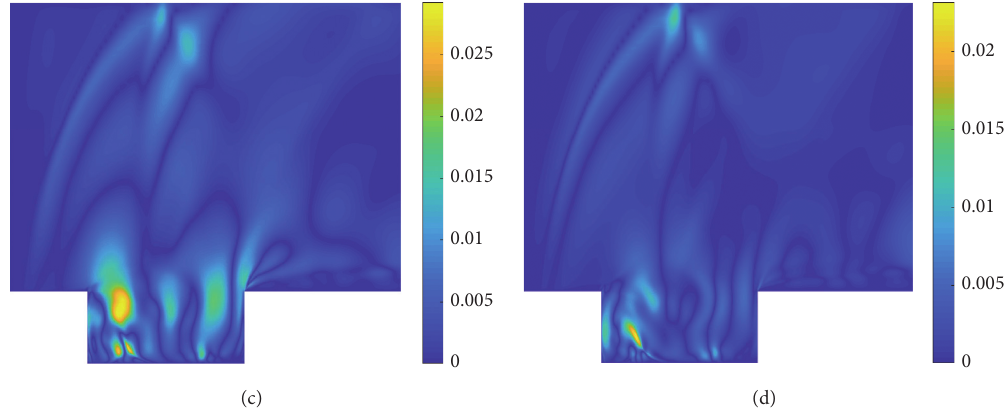
Figure 15: Comparison of RMSE predicted by two deep learning frameworks (Ma � 0.59, 0.6). (a) RMSE (MLP, Ma � 0.59), (b) RMSE